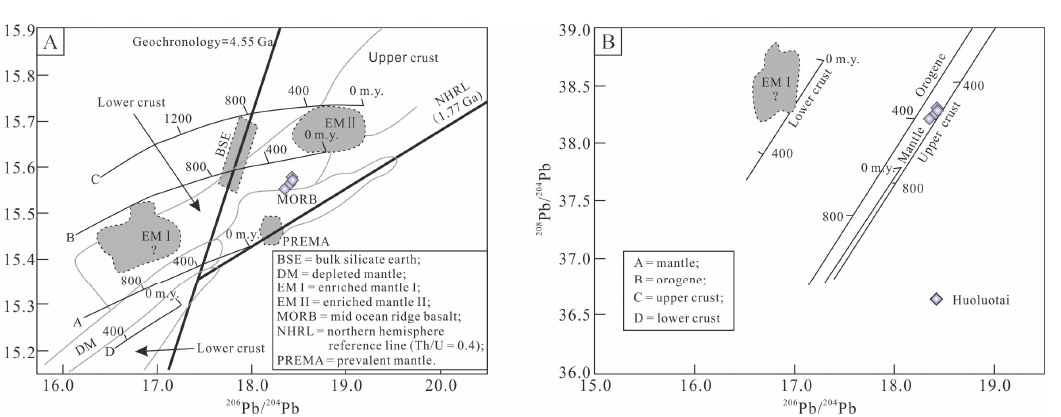
Figure 11. Pb isotope compositions of sulfides from the Huoluotai Cu (Mo) deposit [47]. ( A ) 207 Pb/ 204 Pb vs. 206 Pb/ 204 Pb. ( B ) 208 Pb/ 204 Pb vs. 206 Pb/ 204